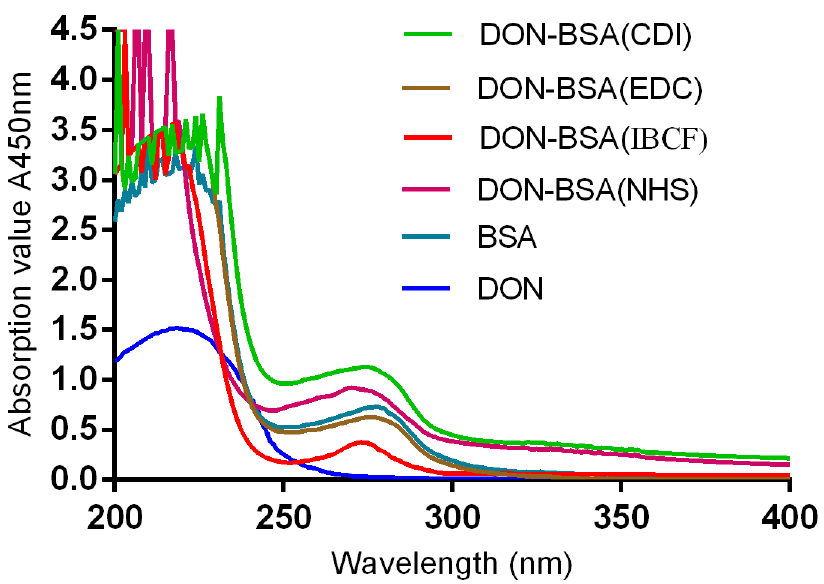
Figure 1. The UV identification of four artificial antigens (DON-BSA). UV: ultra-